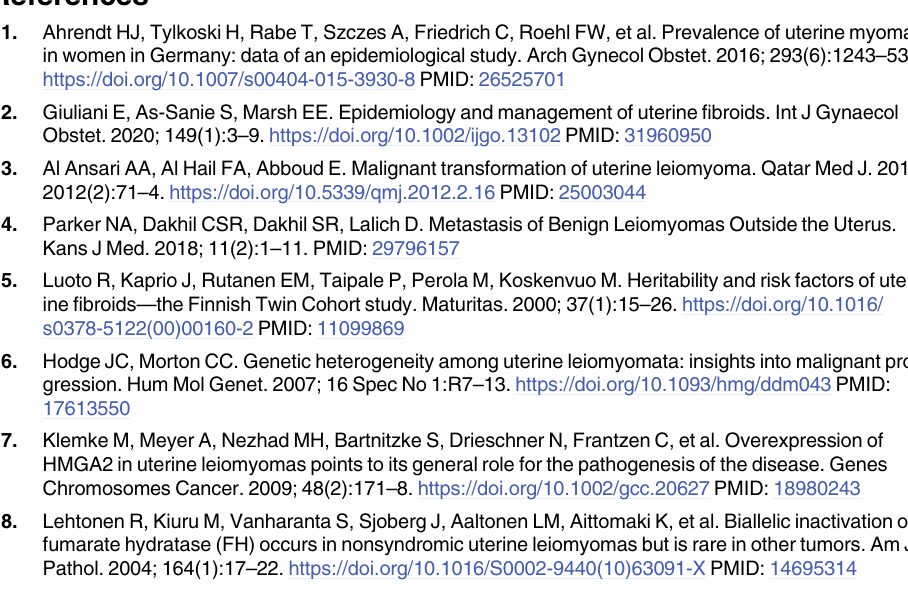
S8 Table. Chemicals that decrease the expression levels of significant TWAS genes nega- tively associated with